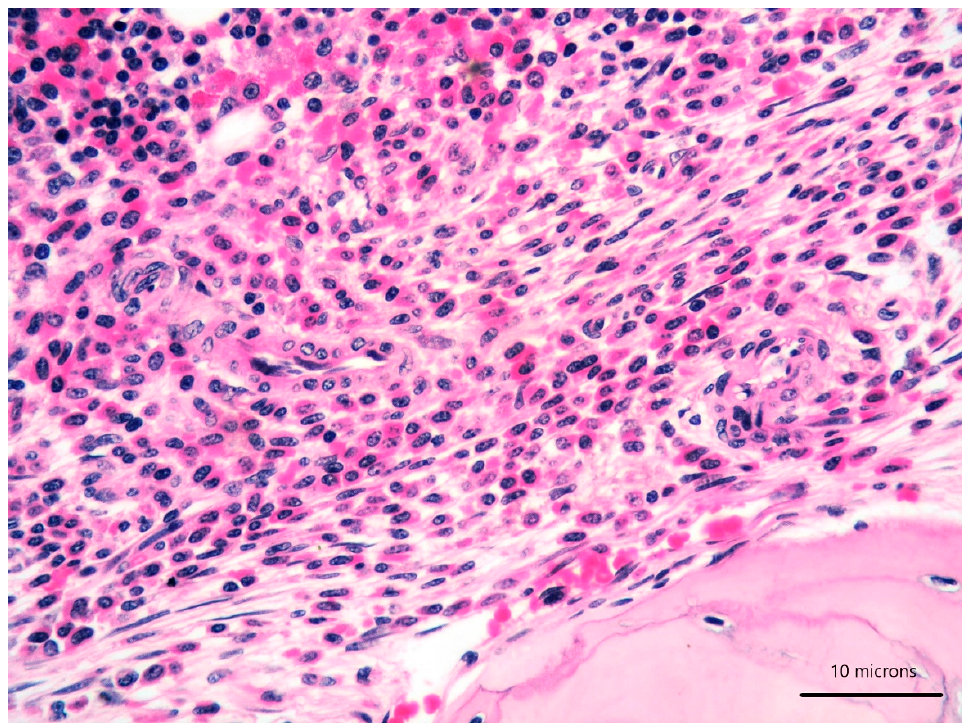
Figure 2. High-power view of bone marrow biopsy highlighting morphological details of bland- looking spindle cells ( lower part ) and mature plasma cells ( upper part ) (haematoxylin and eosin, 400× magnification).